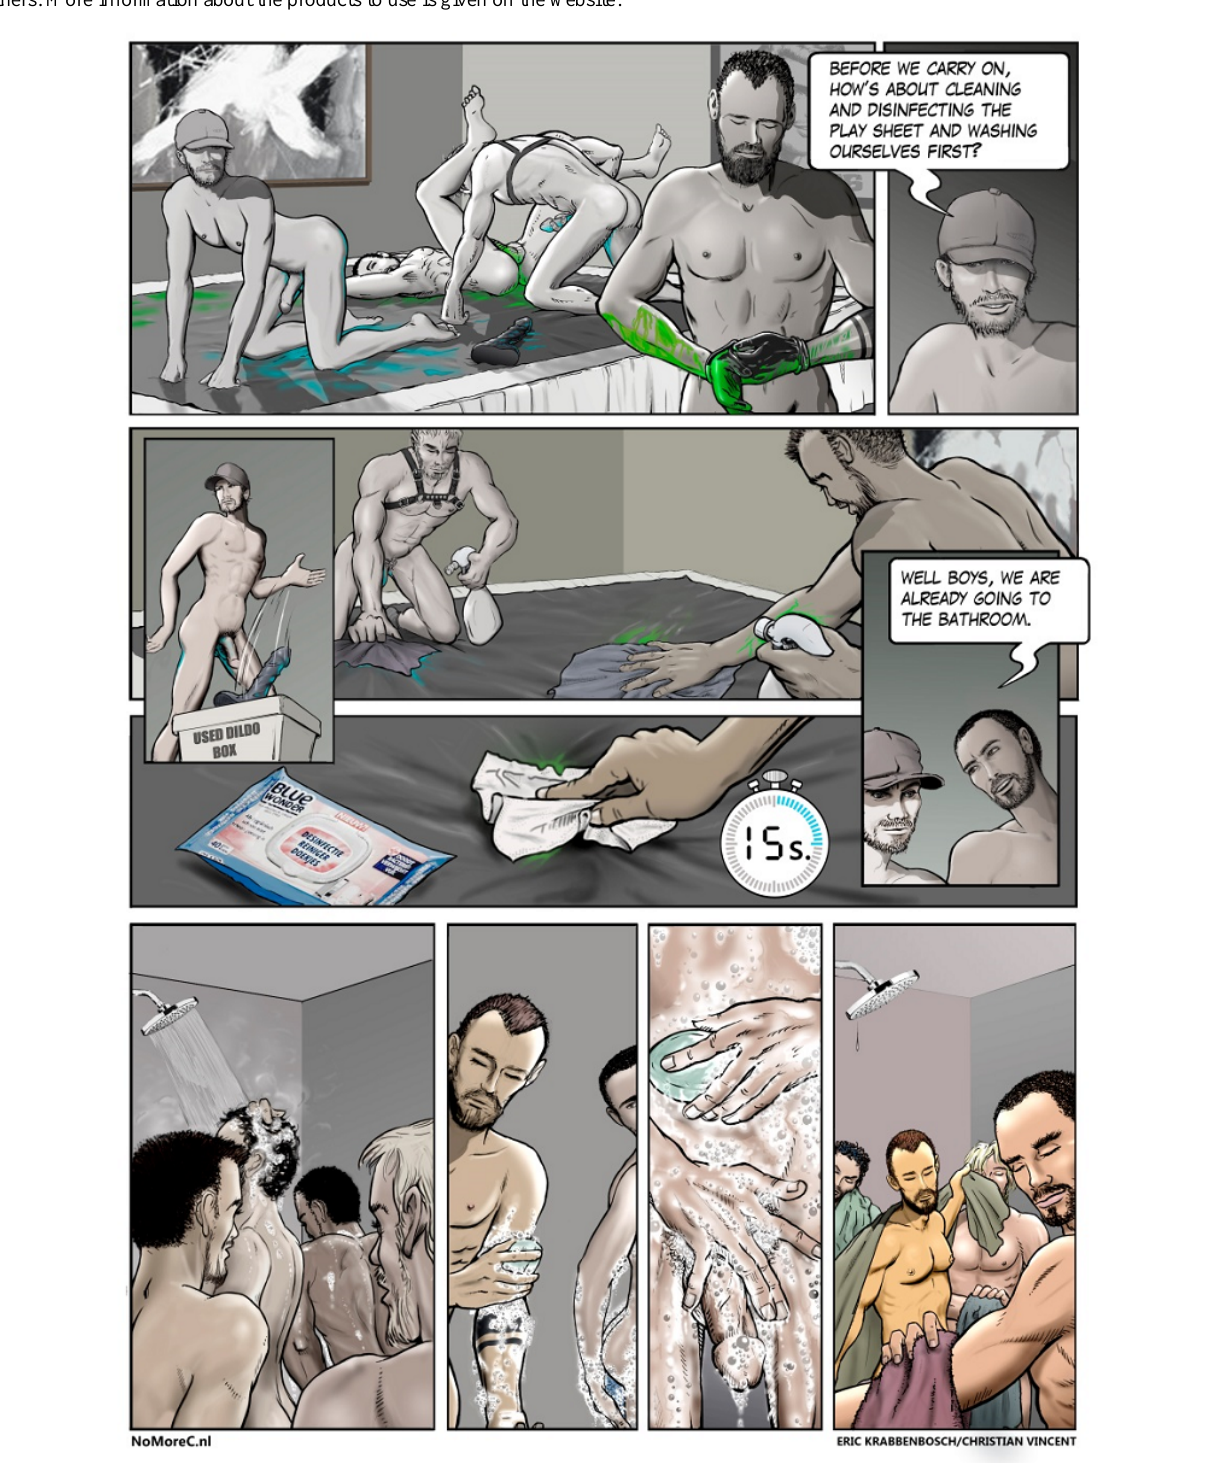
Figure 4. Illustration on the website of a risk reduction strategy: cleaning and disinfection of the play area, toys, and yourself before changing sex partners. More information about the products to use is given on the